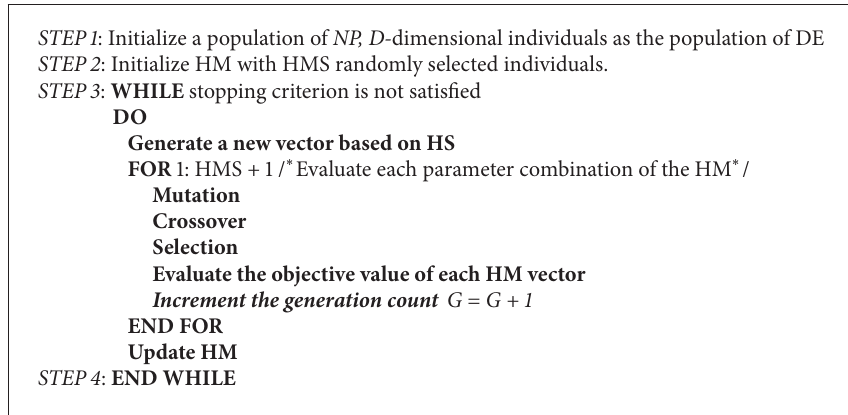
Algorithm 3: Harmony search based parameter ensemble adaptation for DE